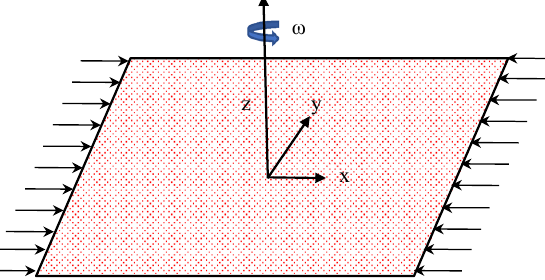
Figure 1. Schematic diagram of the problem under